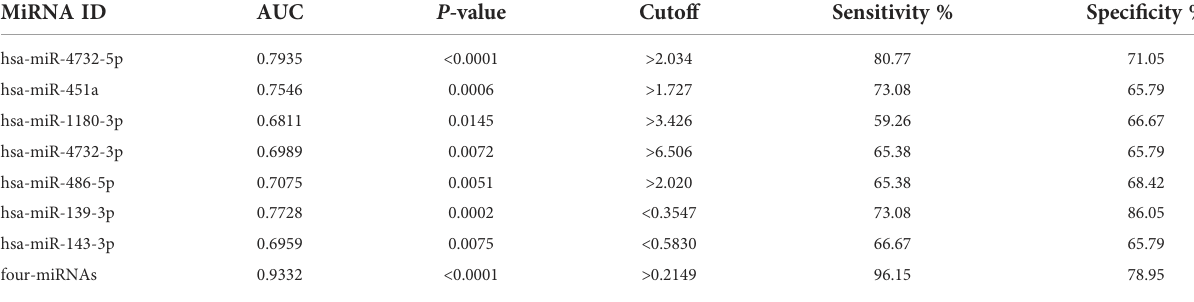
TABLE 3 Diagnostic performances of the seven exosomal DEmiRs for early LUAD. MiRNA ID AUC P -value Cutoff Sensitivity % Speci fi city